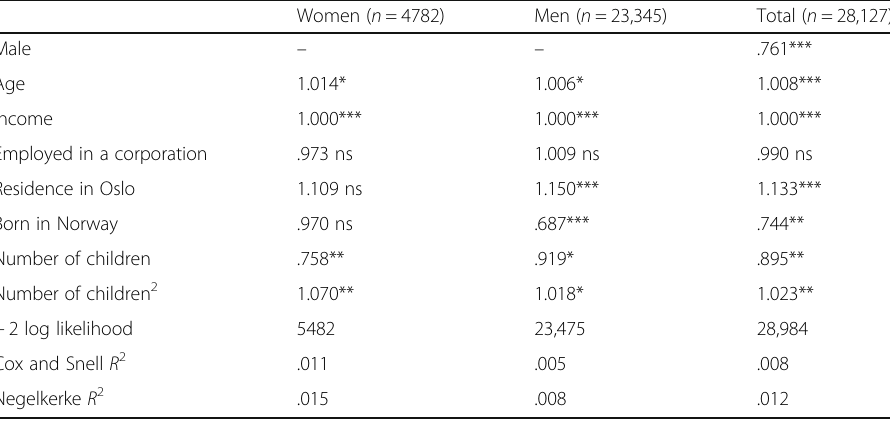
Table 6 Prediction of exit from business